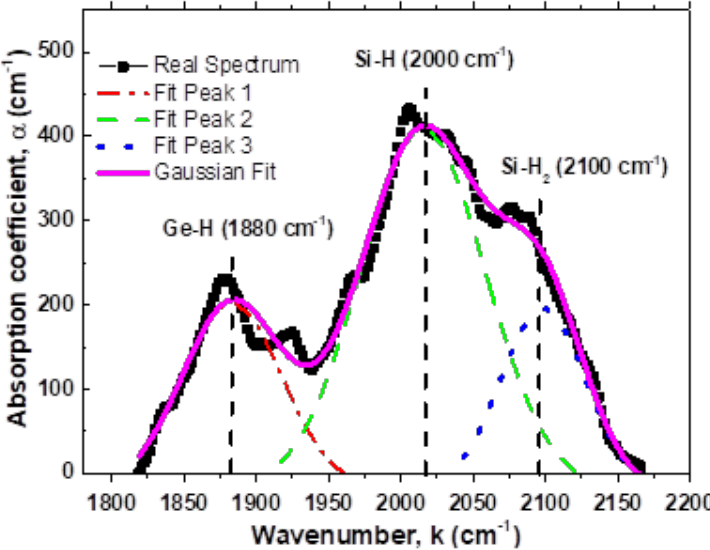
Figure 7. Experimental IR spectrum of stretching vibration modes and deconvolution of Ge–H and Si–H for the SiGe:H films deposited at R H = 09.